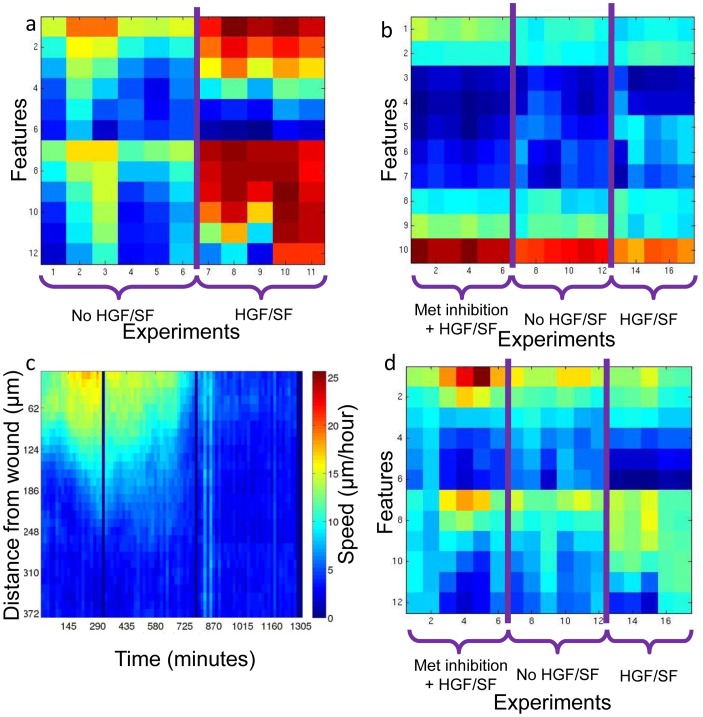
Generalization: multi-cellular speed- and texture-based classification.(a) Velocity magnitude-based vector-representation of a full time lapse sequence. Each column represents a single experiment. The vector values were calculated as the average velocity magnitude of all cells at a given distance-interval from the wound, at a given phase. The analysis demonstrates that the first six experiments (untreated) are very different from the last five (HGF/SF-treated). (b) Texture-based vector-representation of a full time lapse sequence. The LBP image-texture descriptor normalized histogram is averaged over all time frames from Phase 2, when most morphological changes occur. Each column is the LBP histogram extracted from a single experiment. It was demonstrated that there exists a clear discrimination between any pair of the three conditions: untreated, HGF/SF, and Met inhibition+ HGF/SF. (c) Example of a velocity magnitude map of cells treated with Met inhibition and HGF/SF. (d) Collective motility patterns of full time lapse experiments. Each column represents the normalized spatio-temporal velocity magnitude of a single experiment. It was demonstrated that there exists a clear discrimination in collective motility patterns between any pair of the three conditions: untreated, HGF/SF, and Met inhibition + HGF/SF, as Met-signaling becomes more active, the ratio between motility of distant cells and close cells decreases which implies that cells located farther from the wound become more active by Met-signaling activation.